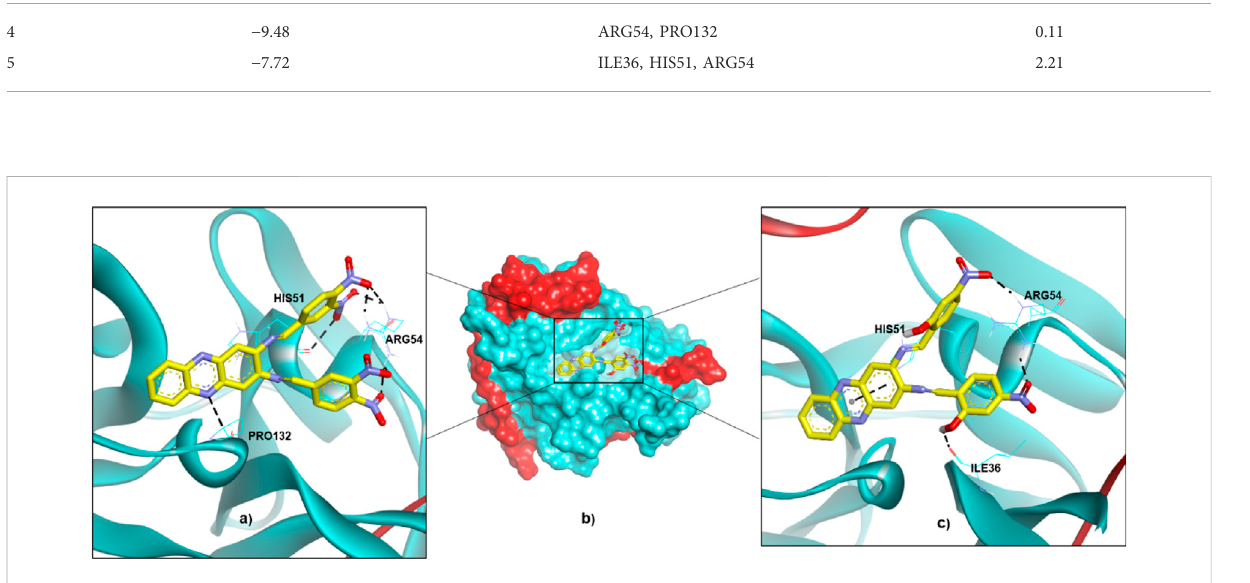
FIGURE 6 The binding conformations of compounds 4 and 5 in the binding pocket of DENV2 NS2B-NS3 protease are represented by (A) 4 in a ribbon protein model, (B) 4 and 5 in a surface protein model, and (C) 5 in a ribbon protein model.